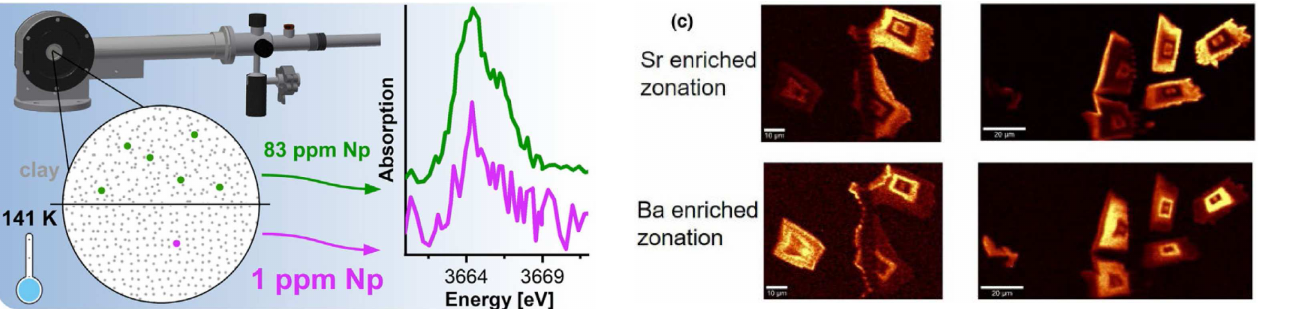
Fig. 4. M5-edge HR-XANES spectra of Np absorbed on illite at (83 ± 2 ppm) and (1.24 ± 0.04 ppm) loading recorded at 141.2 ± 1.5 K at newly developed setup at ACT station of the CAT-ACT beamline at the KIT Light Source (adapted after Schacherl et al. [4]).